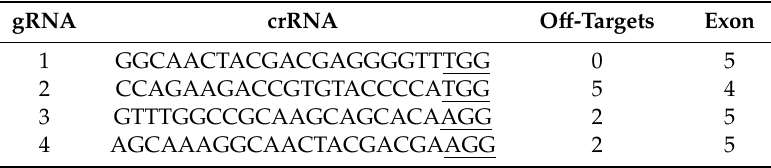
Table 3. Sequences of the CRISPR RNA (crRNA) used in this study. gRNA